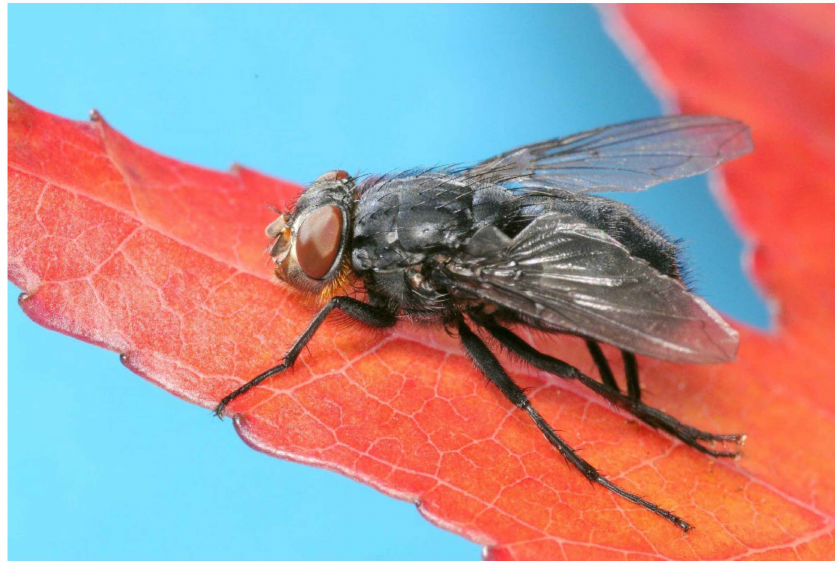
Figure 2. The blowfly Calliphora vomitoria L. (Diptera: